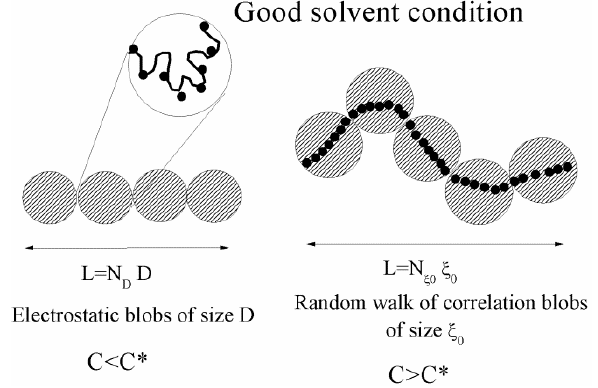
Figure 1. A sketch of a polyelectrolyte chain in good-solvent conditions, for different (salt free) concentration regimes. The chain is an extended rodlike configuration of electrostatic blobs and a random walk of correlation blobs for dilute ( C < C *) and semidilute ( C > C *) regimes,